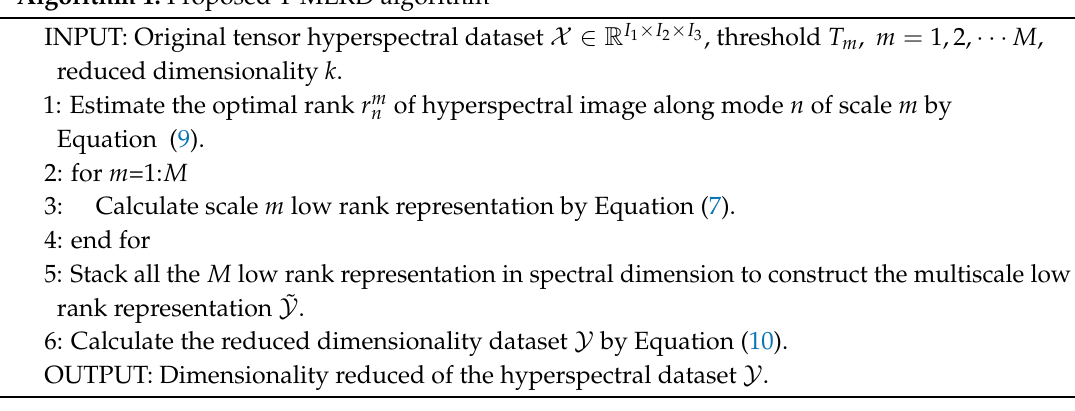
Algorithm 1: Proposed T-MLRD